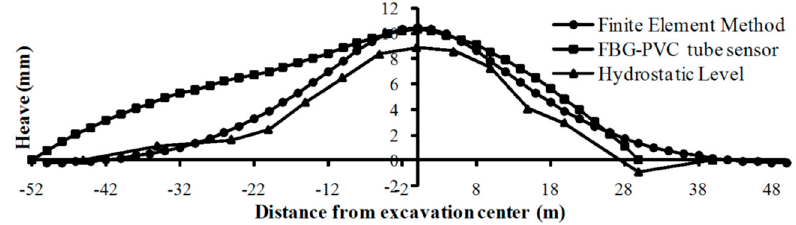
Figure 11. Comparison of tunnel heaves from finite element analysis, FBG sensors and Hydrostatic Level [79].